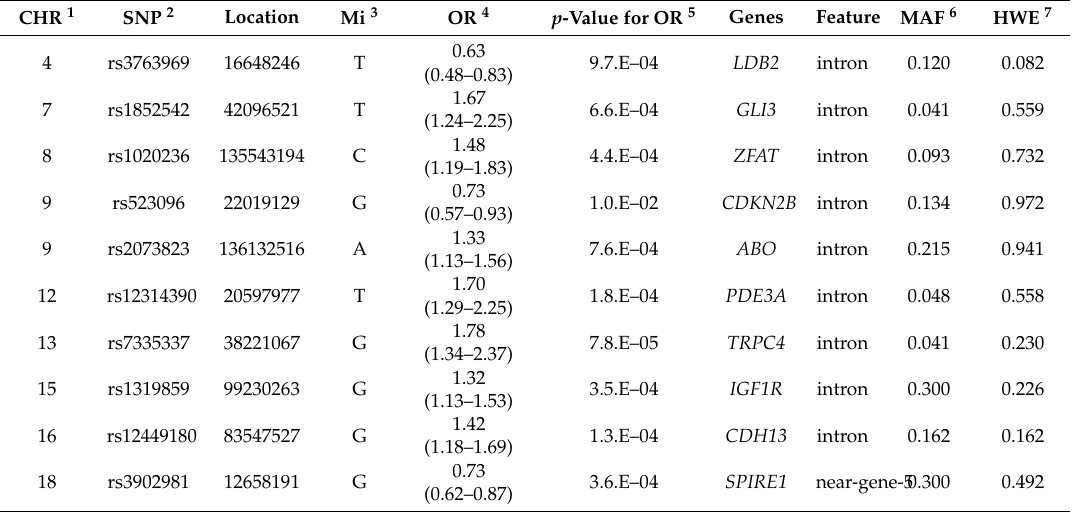
Table 3. The characteristics of the ten genetic variants of genes related to glaucoma risk used for the generalized multifactor dimensionality reduction